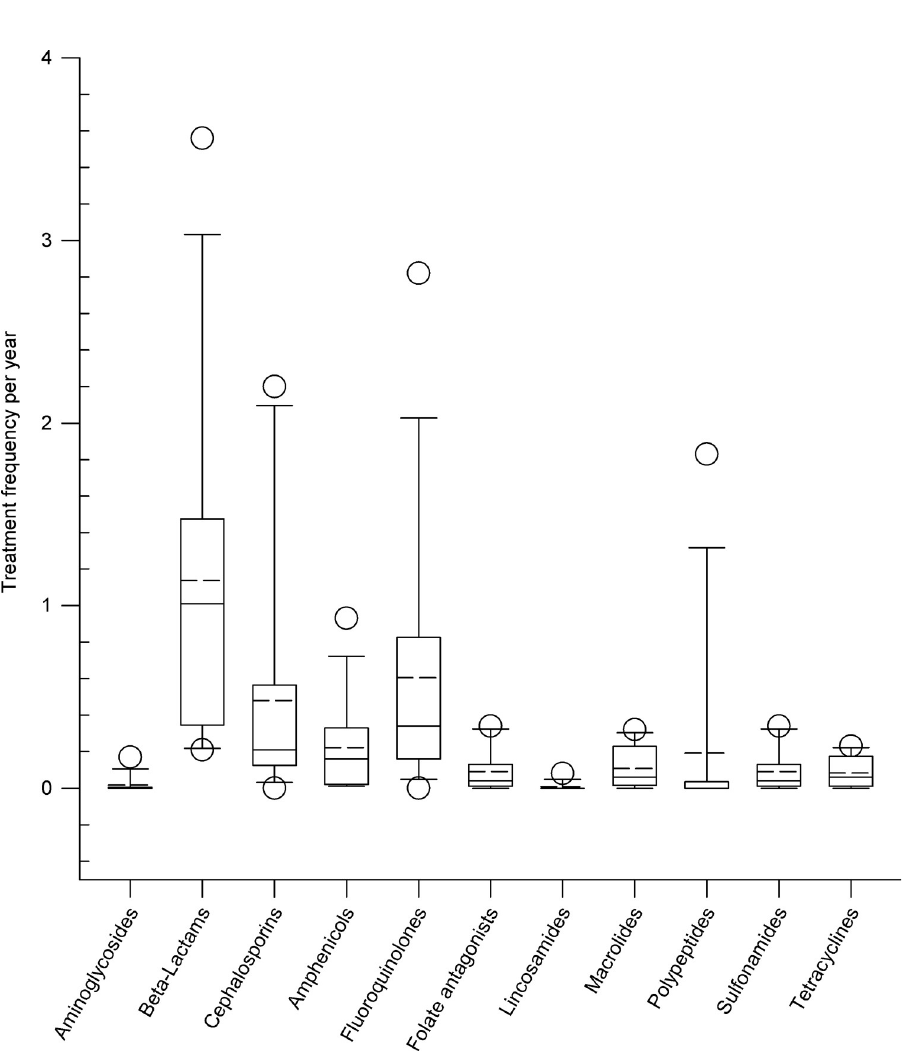
Fig 3. Administration of different antimicrobial classes after parenteral application expressed as treatment frequencies per animal and year on nine dairy farms. Box, the range between the 1 st (Q1) and 3 rd (Q3) quartile; horizontal line, median; dashed line, mean; circles, outlying points (5 th , 95 th percentiles,